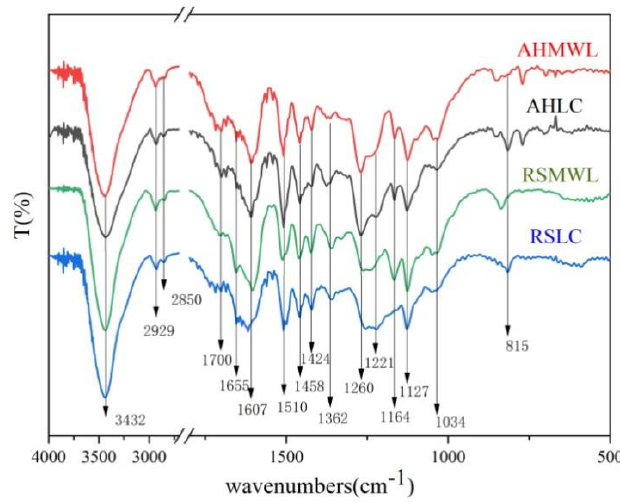
Figure 2. Infrared spectra of AHMWL, AHLC, RSMWL, and